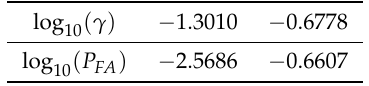
( γ ) ,log ( P )) in N = FA 10 10